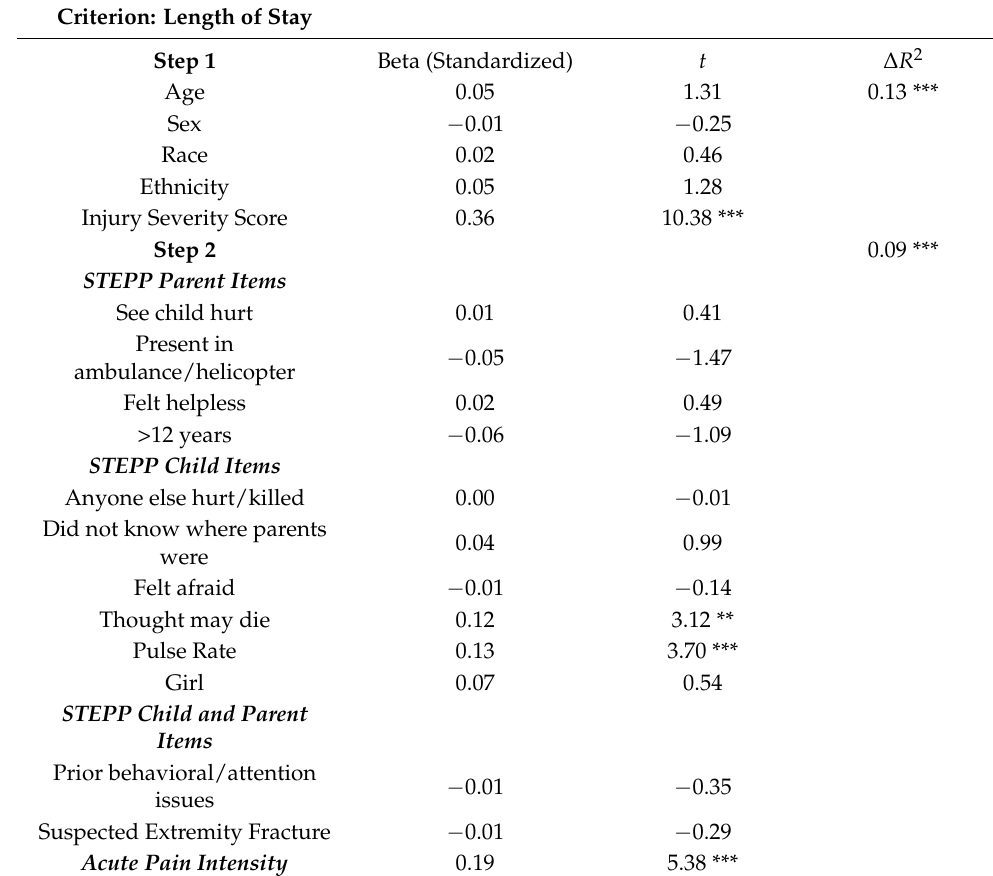
Table 3. Hierarchical Multiple Regressions Predicting Length of